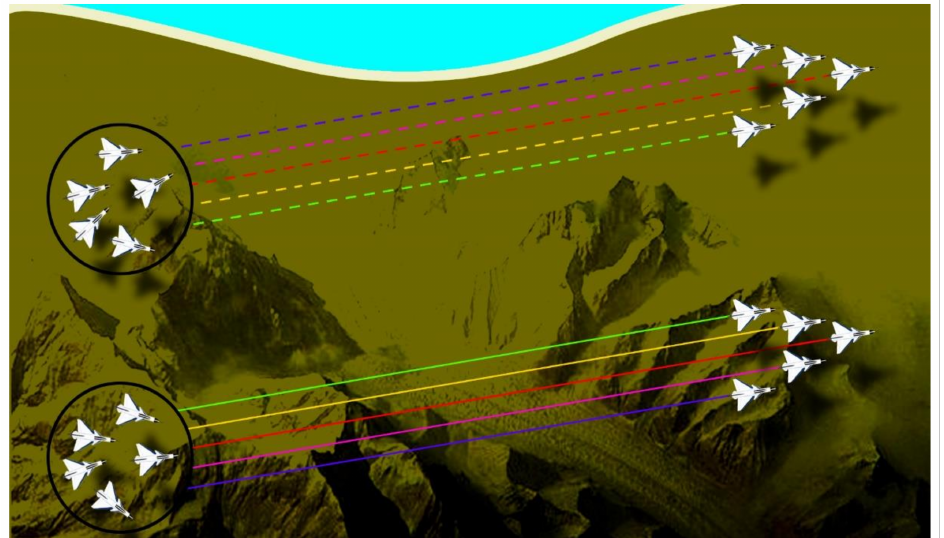
Figure 1. Scenario 1 containing 10 UAVs divided into two clusters in random positions on the left; the two clusters are in leader-follower formation on the